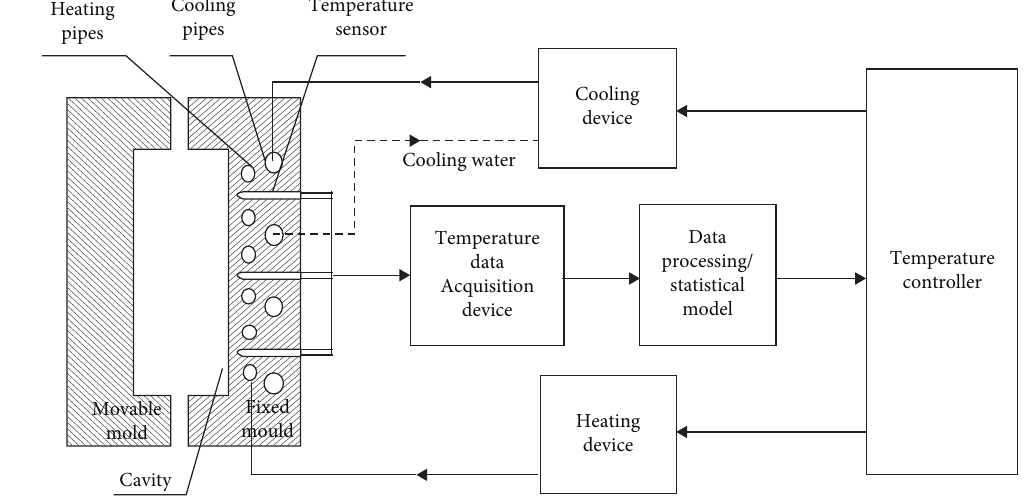
Figure 1: Schematic diagram of RHCM apparatus [32]. Table 1: Processing parameters used in RHCM tests.